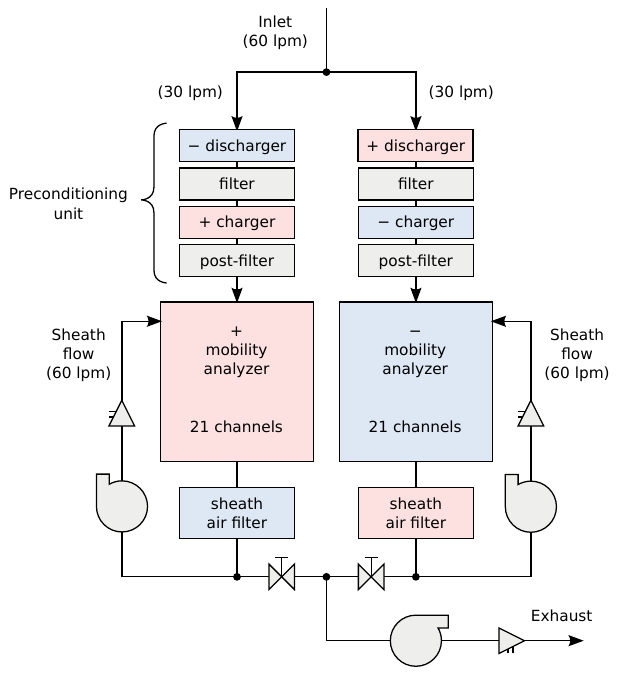
Fig. 1. NAIS measurement flow